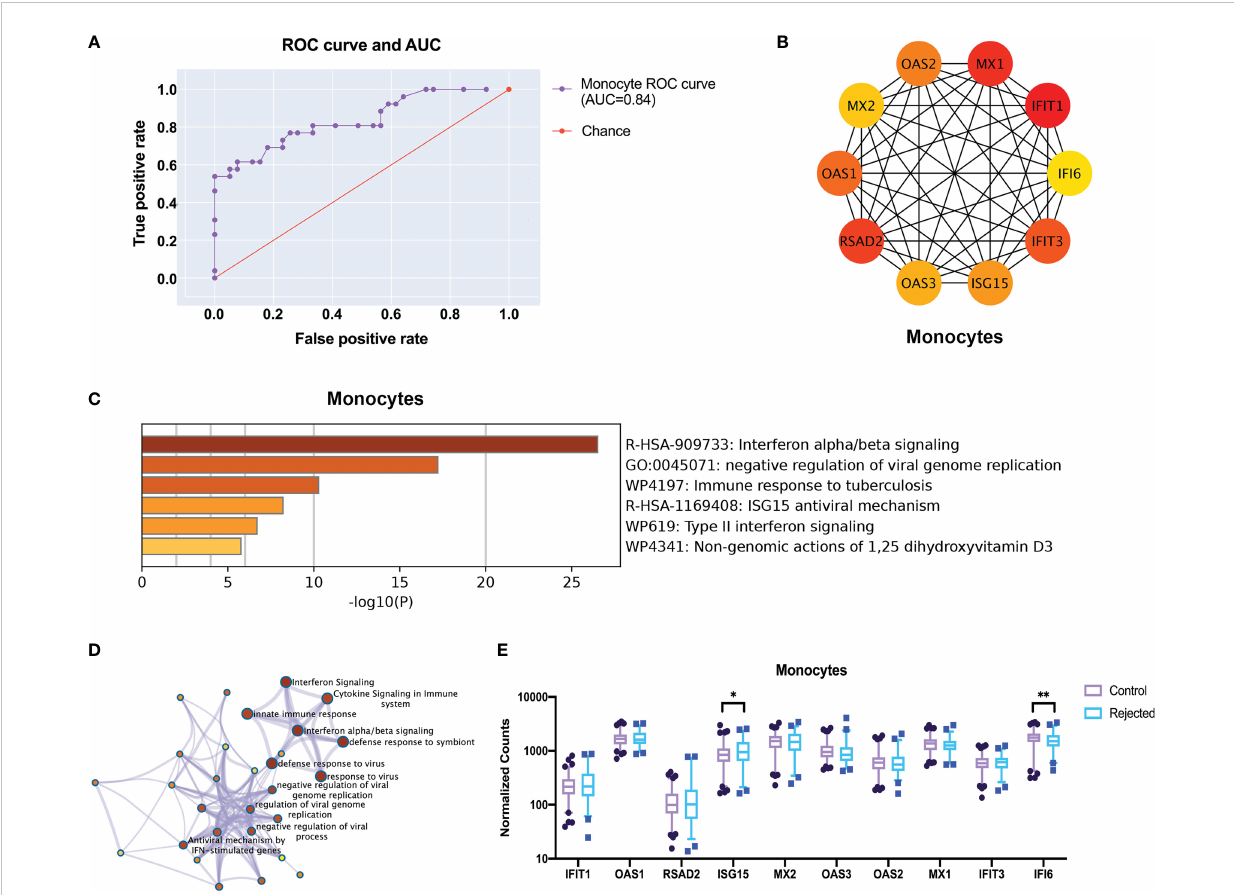
FIGURE 6 Screen the top 10 robust different expression genes for prediction through transcriptome and protein interactions. (A) The ROC curve and AUC show the performance of a classi fi cation model at thresholds in all rejection samples of monocytes. (B) The protein-protein interactions network shows the 10 hub genes with high connectivity in monocytes after feature selection by LASSO regression. (C) The metabolic pathway enriches by GO. (D) The network of enriched clusters represents the most signi fi cant term of biological process and metabolic pathway. (E) The boxplots show the expression of the hub genes in the deconvoluted gene expressions. ROC curve, receiver operating characteristic curve; AUC, area under the ROC curve. *p < 0.05 **p <